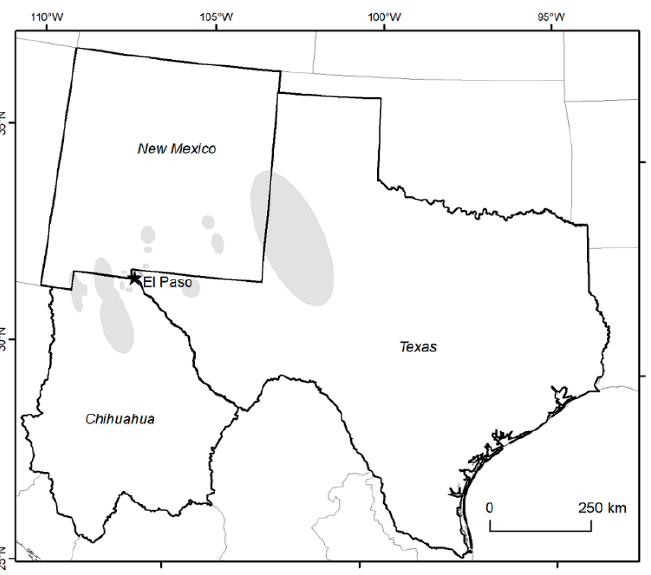
Figure 1. Location of El Paso, Texas with regards to the surrounding states. Major dust source regions impacting the city [8,9] are shaded.